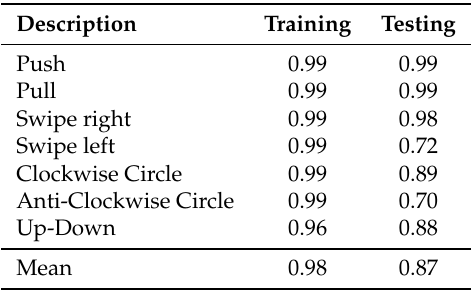
Table 3. Training and testing accuracy scores for the 7 gestures. Score is measured as the mean of recognised time steps for each